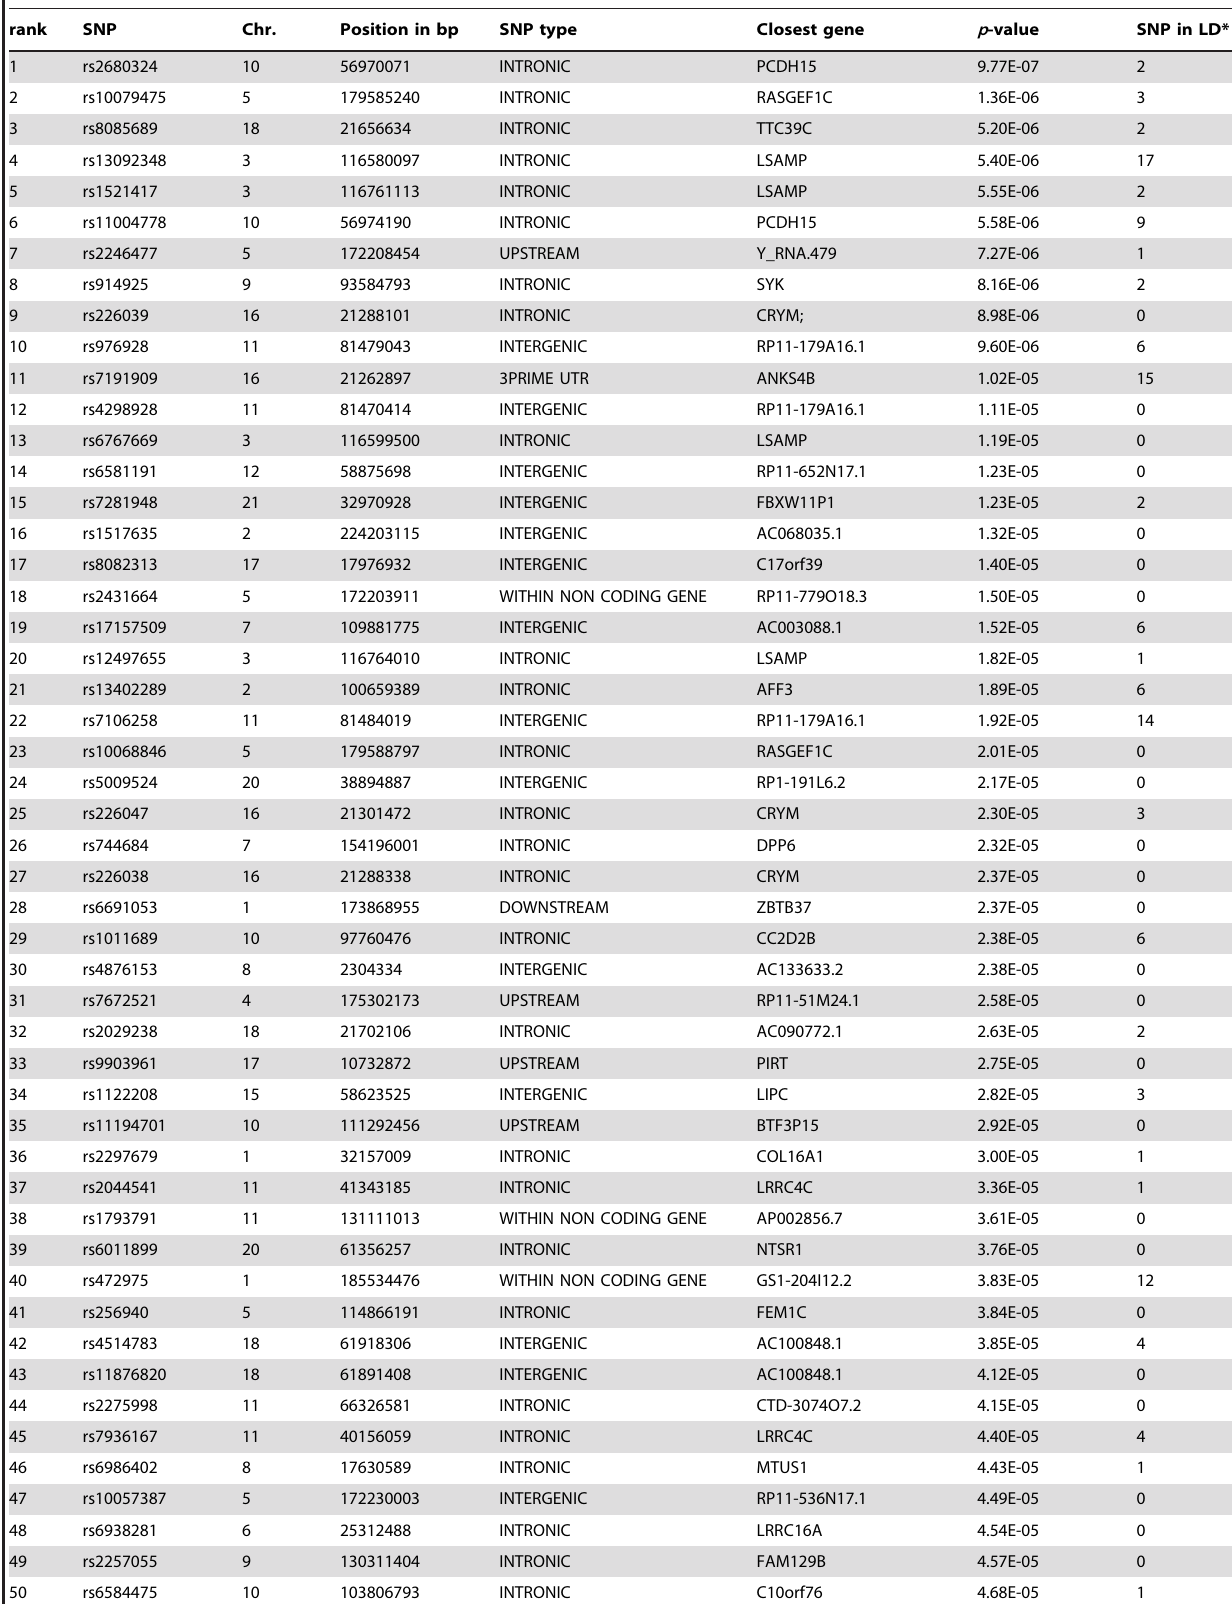
Table 1. Top 50 most associated SNPs in 9538 individuals after pruning for LD (r 2 , 0.8).